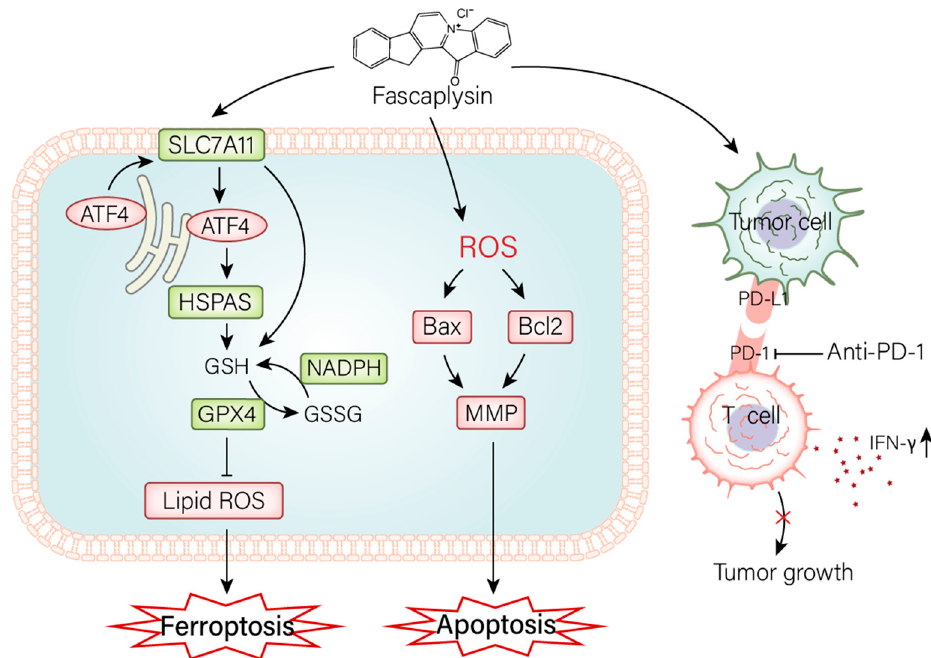
Figure 8. The mechanism of fascaplysin inhibiting the growth of NSCLC in vitro and in vivo. In vitro, fascaplysin induced apoptosis by promoting the elevation of ROS. It induced ferroptosis by modulating the GPX4 signaling pathway and provoked ER stress. In vivo, fascaplysin improved the sensitivity of anti-PD-1 immunotherapy, which in turn inhibited tumor growth.